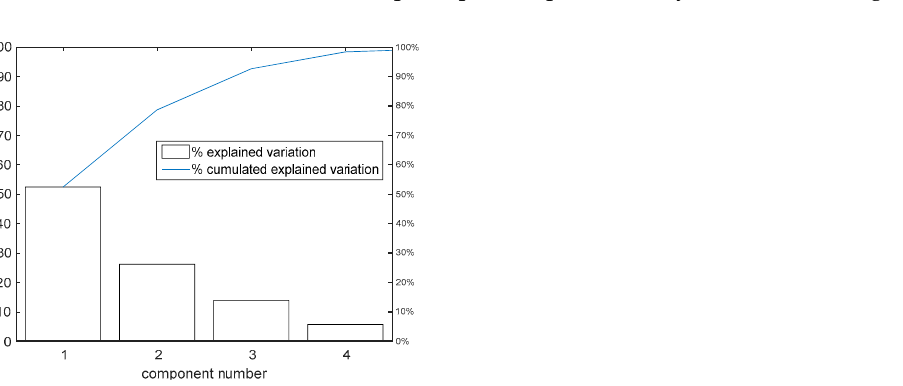
Figure 9. Proportion of state variation explained as function of the number of principal components, for VSFRT state input.